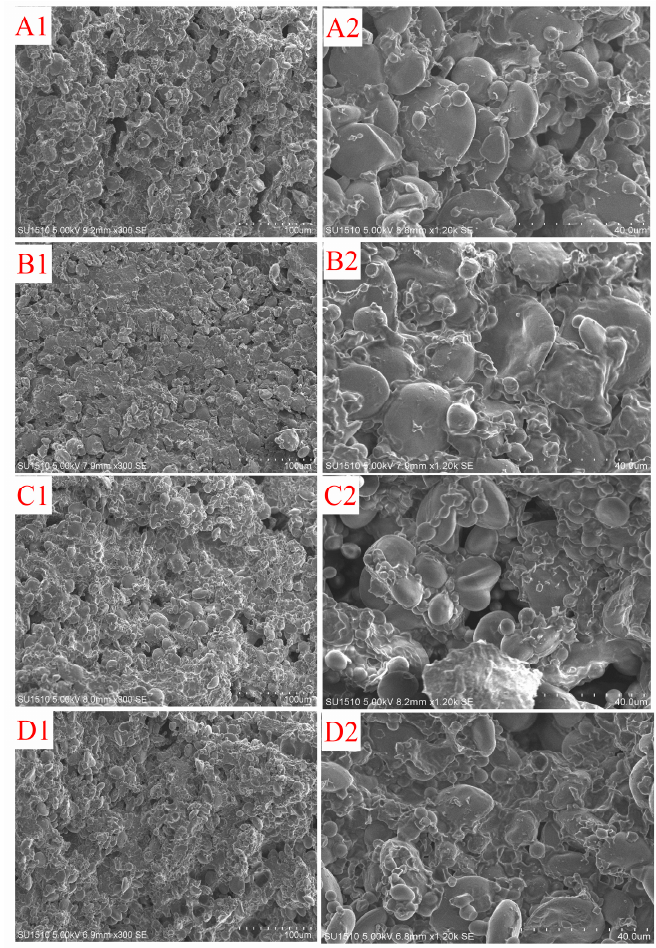
Figure 2. E ff ect of BaAFP-1 on the microstructure of dough samples. ( A , B ) stand for control and BaAFP-1 dough samples after frozen treatment, respectively; ( C , D ) stand for control and BaAFP-1 dough samples after freeze-thaw treatment, respectively; number 1 and 2 after ( A – D ) in the figure represent 300 × and 1200 × magnification, respectively.